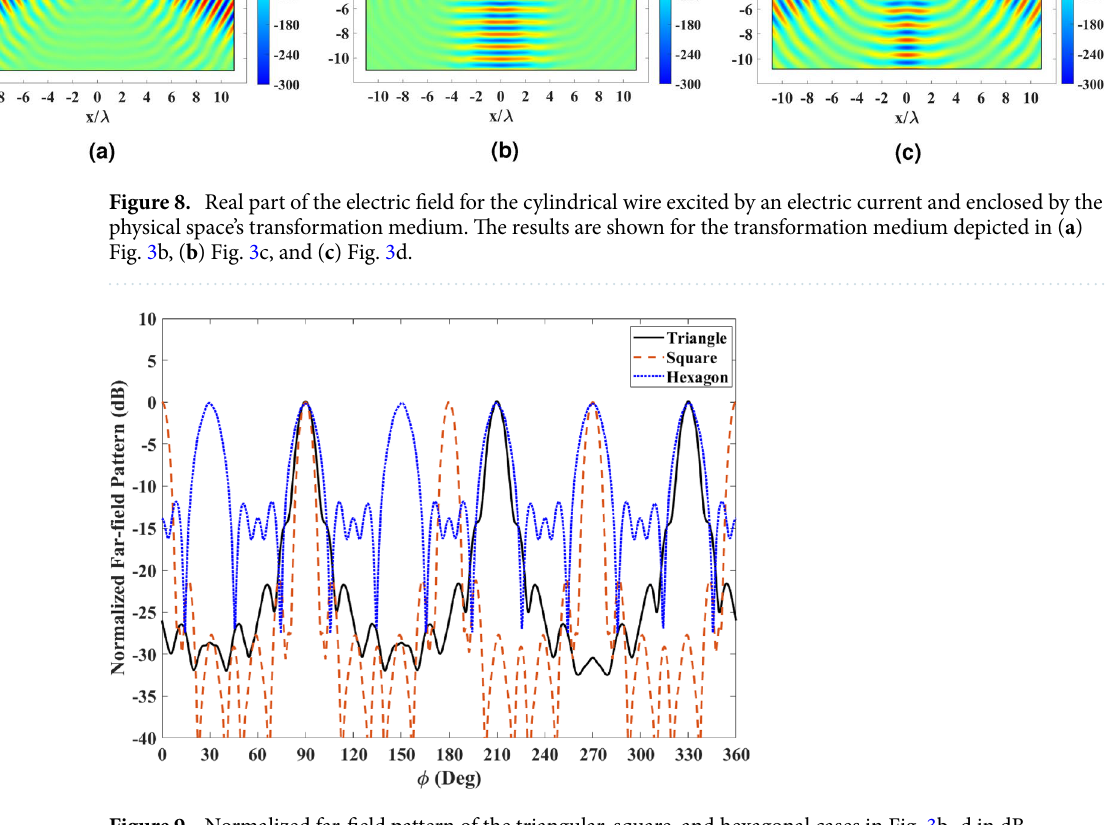
Figure 9. Normalized far-field pattern of the triangular, square, and hexagonal cases in Fig. 3b–d in